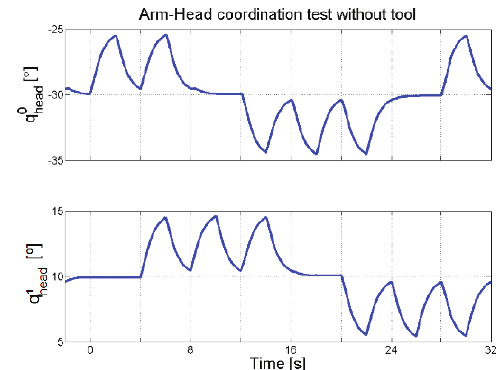
Figure 19. Head joints positions trajectory with respect to time during the arm- head coordination test performed without the